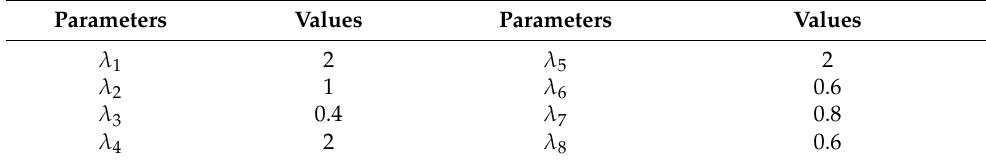
Table 6. Initial parameters’